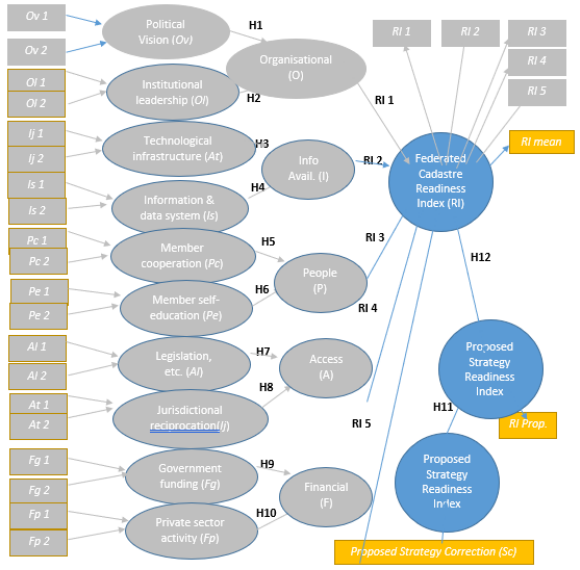
Figure 7 . PLSSEM analysis hypotheses model – proposed strategy